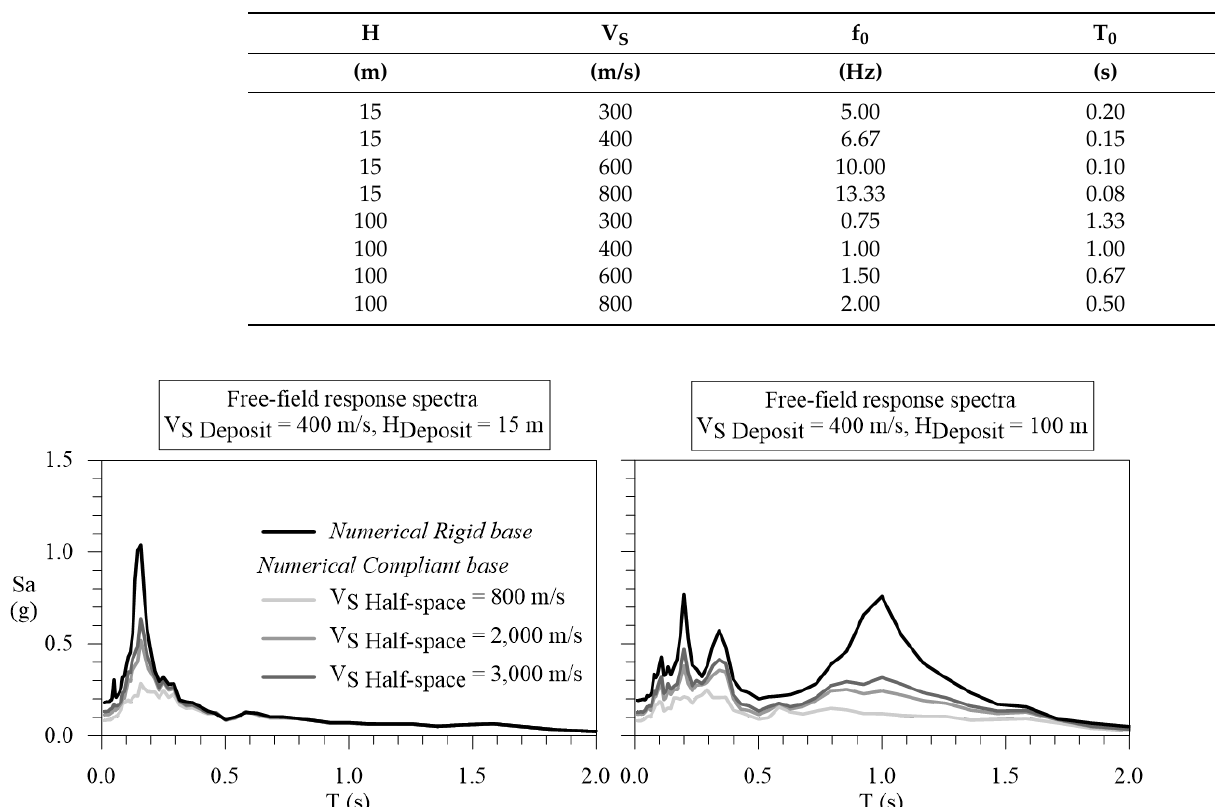
Figure 2. Response spectra of the reference motions in pseudo-spectral acceleration referring to: ( a ) homogeneous case studies and ( b ) heterogeneous case studies. Table 1. Theoretical fundamental frequencies and periods related to the selected homogeneous case studies.